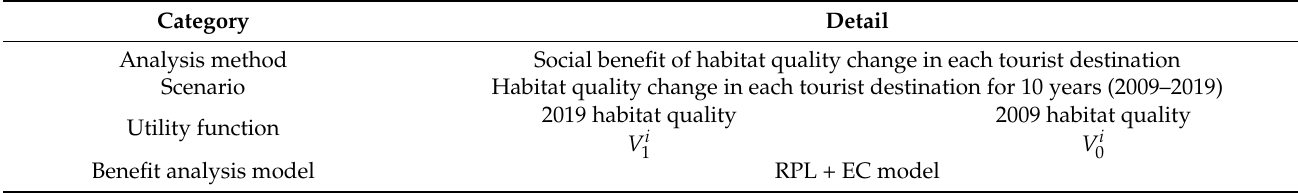
Table 6. Benefit estimation scenario.